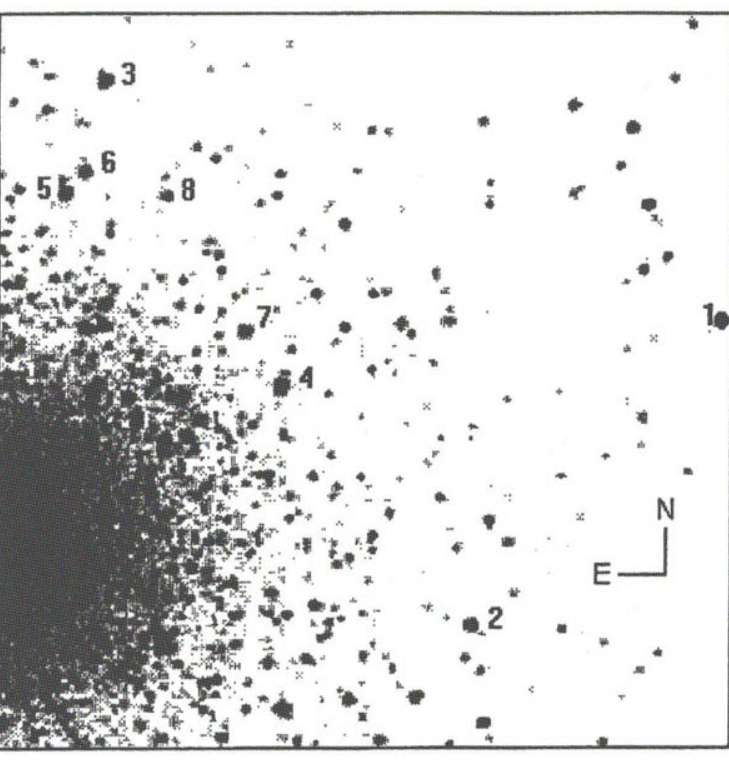
Fig. 1. Finding chart for the standard stars in